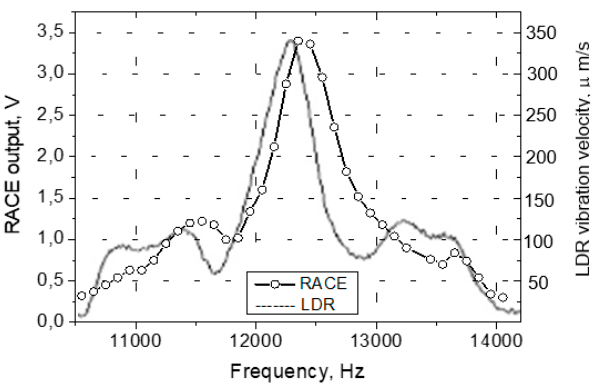
Figure 3. Comparison of RACE and LDR frequency responses for FBH in PMMA plates.